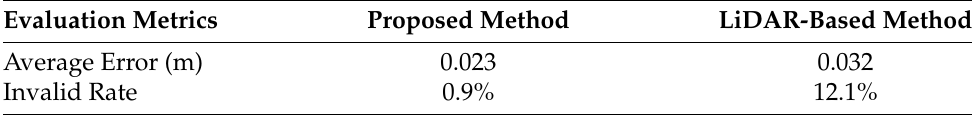
Table 4. Average error and invalid rate of the testing route with curving